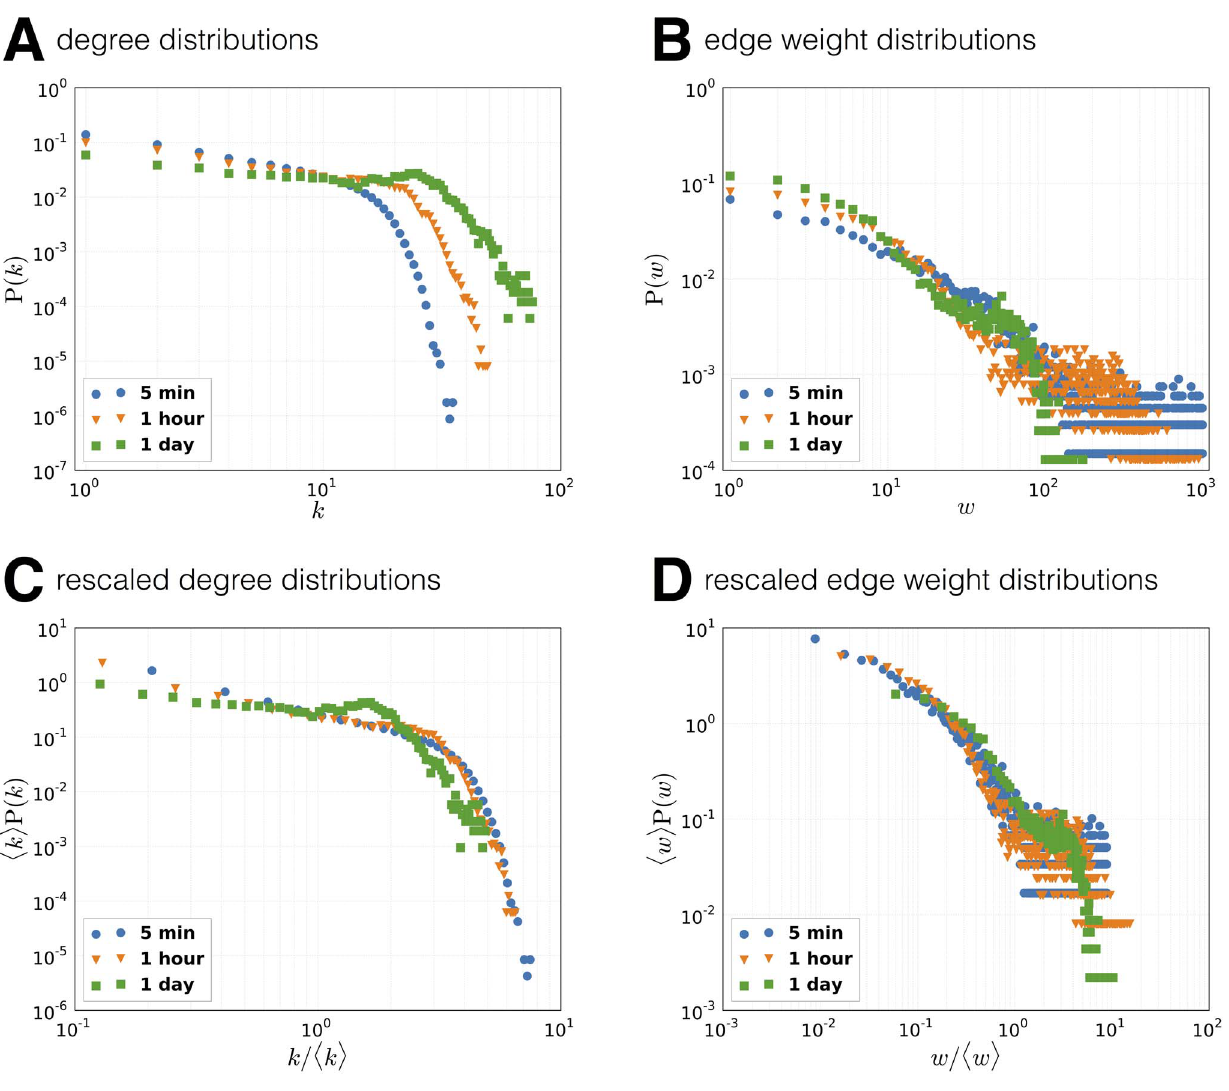
Figure 6. Face-to-face network properties at different resolution levels. Distributions are calculated by aggregating sub-distributions across temporal window. Differences in rescaled distributions suggest that social dynamics unfold on multiple timescales.